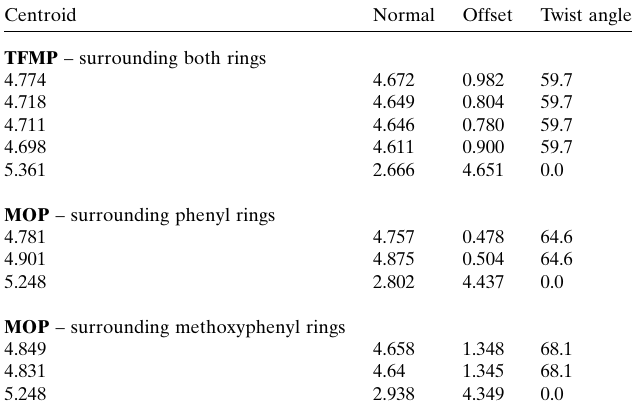
Table 3 (cid:2) -stacking parameters for TFMP and MOP .